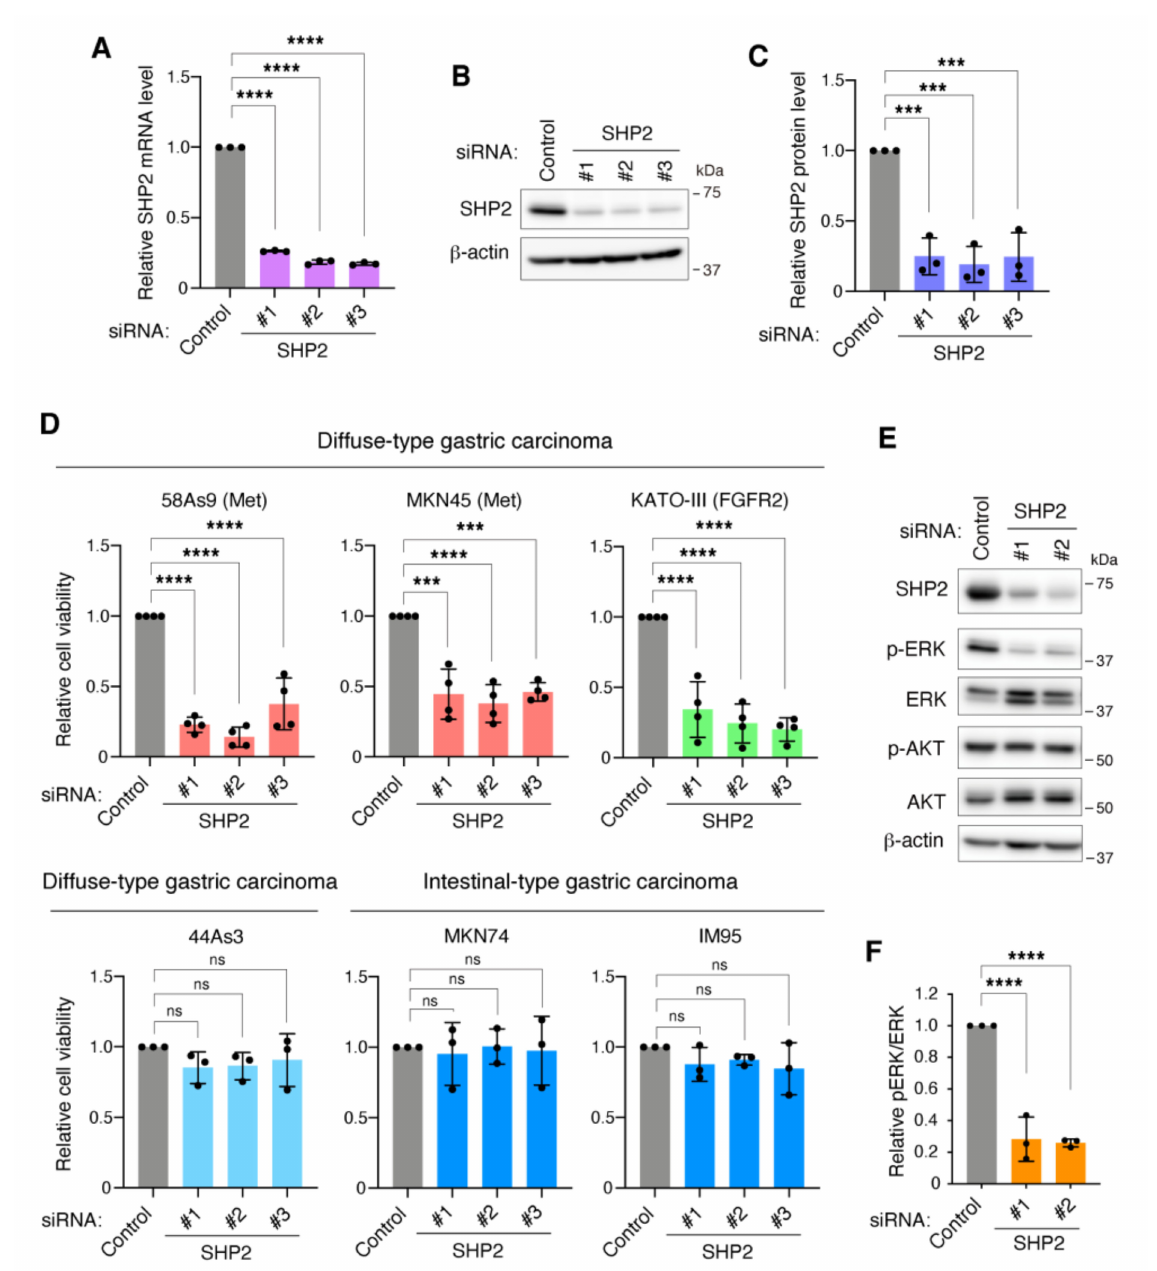
Figure 3. SHP2 is required for the growth of DGC cells addicted to Met or FGFR2. ( A ) 58As9 cells transfected with control or SHP2 siRNAs were subjected to qPCR analysis. Bars, SD ( n = 3). ****, p < 0.0001. ( B ) 58As9 cells transfected with siRNAs were subjected to immunoblot analysis. ( C ) Quantitative analysis of immunoblot data for SHP2 protein levels. Bars, SD ( n = 3). ***, p < 0.001. ( D ) Gastric carcinoma cells were transfected with control or SHP2 siRNAs for 6 days and examined for their viability. Bars, SD ( n = 4 for 58As9, MKN45, KATO-III and 3 for others). ***, p < 0.001; ****, p < 0.0001, ns = not significant. ( E ) 58As9 cells transfected with siRNAs were subjected to immunoblot analysis. ( F ) Quantitative analysis of ERK phosphorylation. Bars, SD ( n = 3). ****, p <